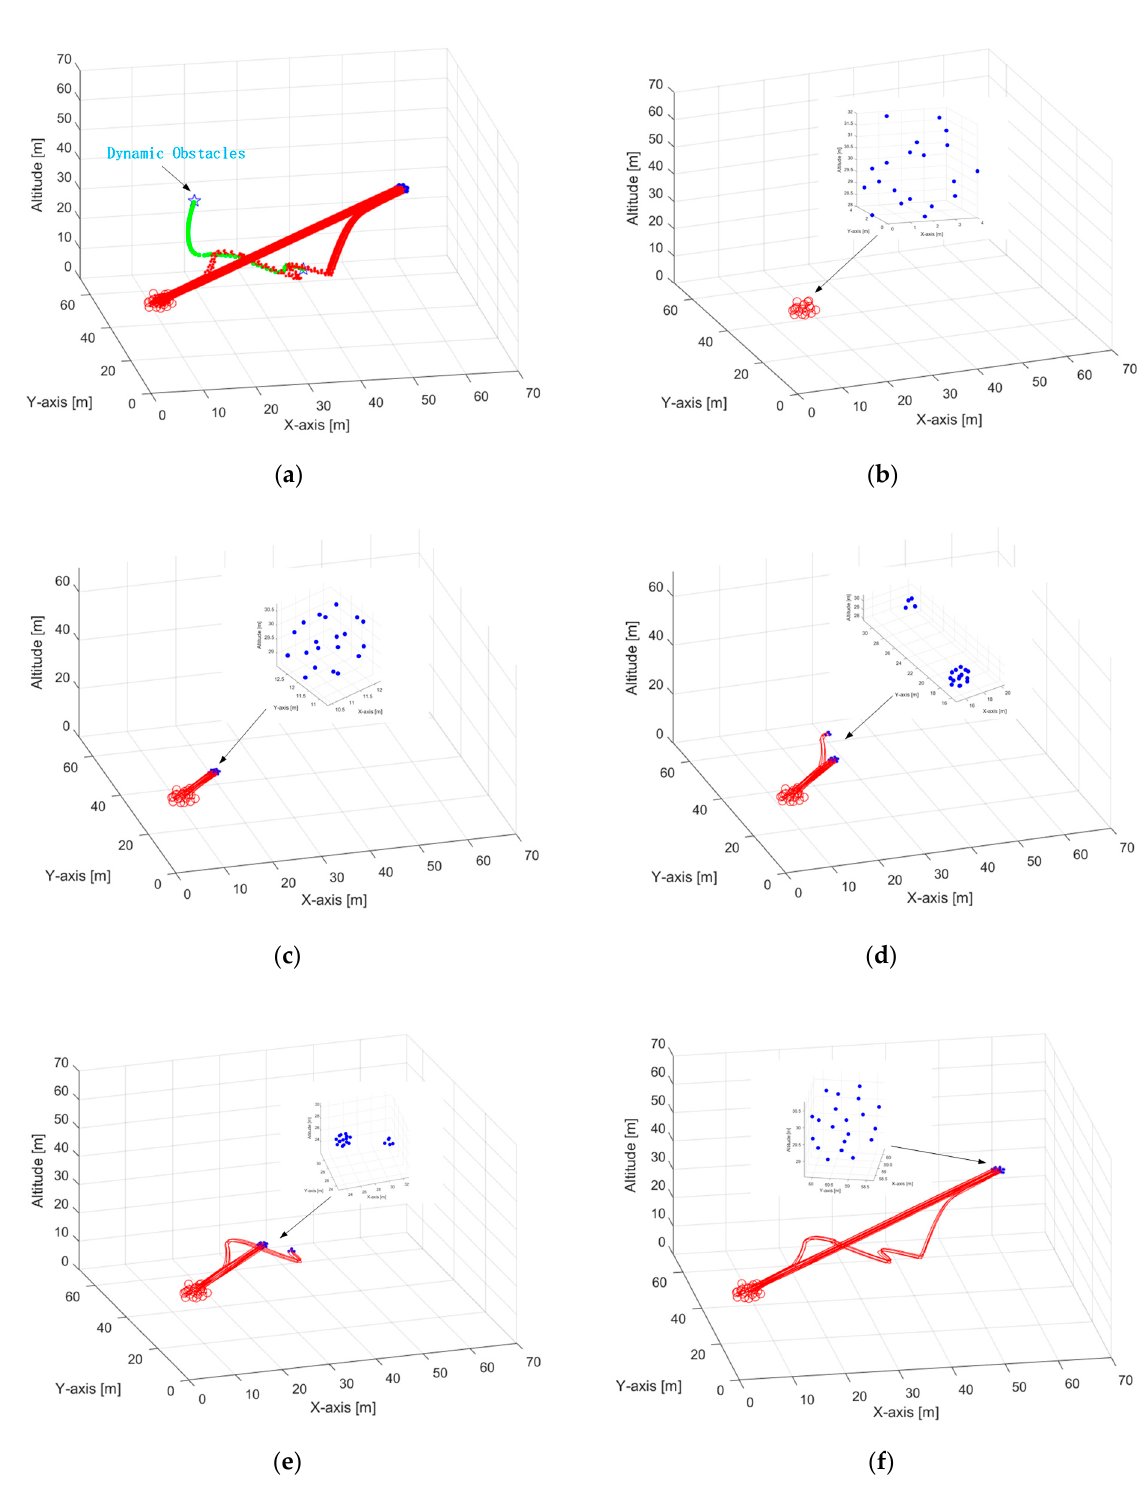
Figure 6. Fission–fusion process of UAV swarm under the anti-capture situation. ( a ) the process of the complete UAV swarm fission–fusion; ( b ) the initial state of the UAV swarm; ( c ) the swarm quickly forms a stable swarm state; ( d ) the swarm performs fission movement and traps dynamic obstacles; ( e ) sub-swarm to dynamic obstacles for re-capture movement; ( f ) the sub-swarm completes trapping and returns to the mother swarm for fusion.